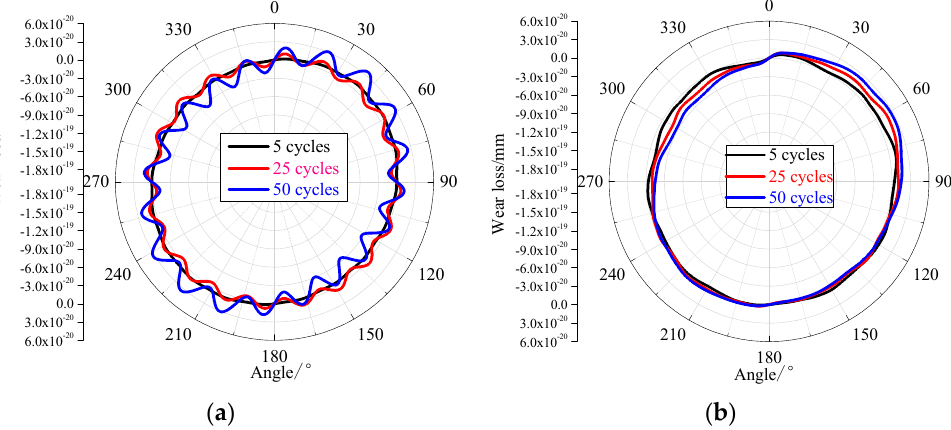
Figure 18. Polygonal wear results obtained by superposing the uneven wear of the wheels rolling with cycles, ( a ) D = 920 mm, ( b ) D = 900 mm.